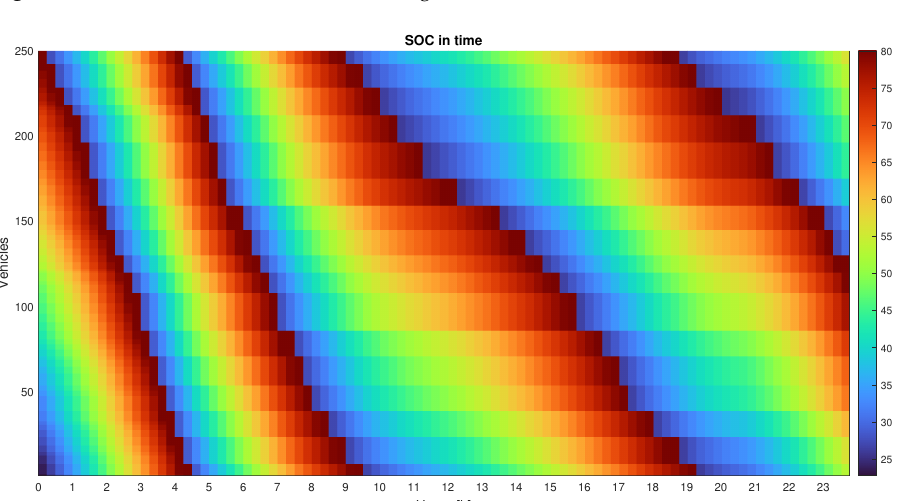
Figure 13. Smart current with PV and